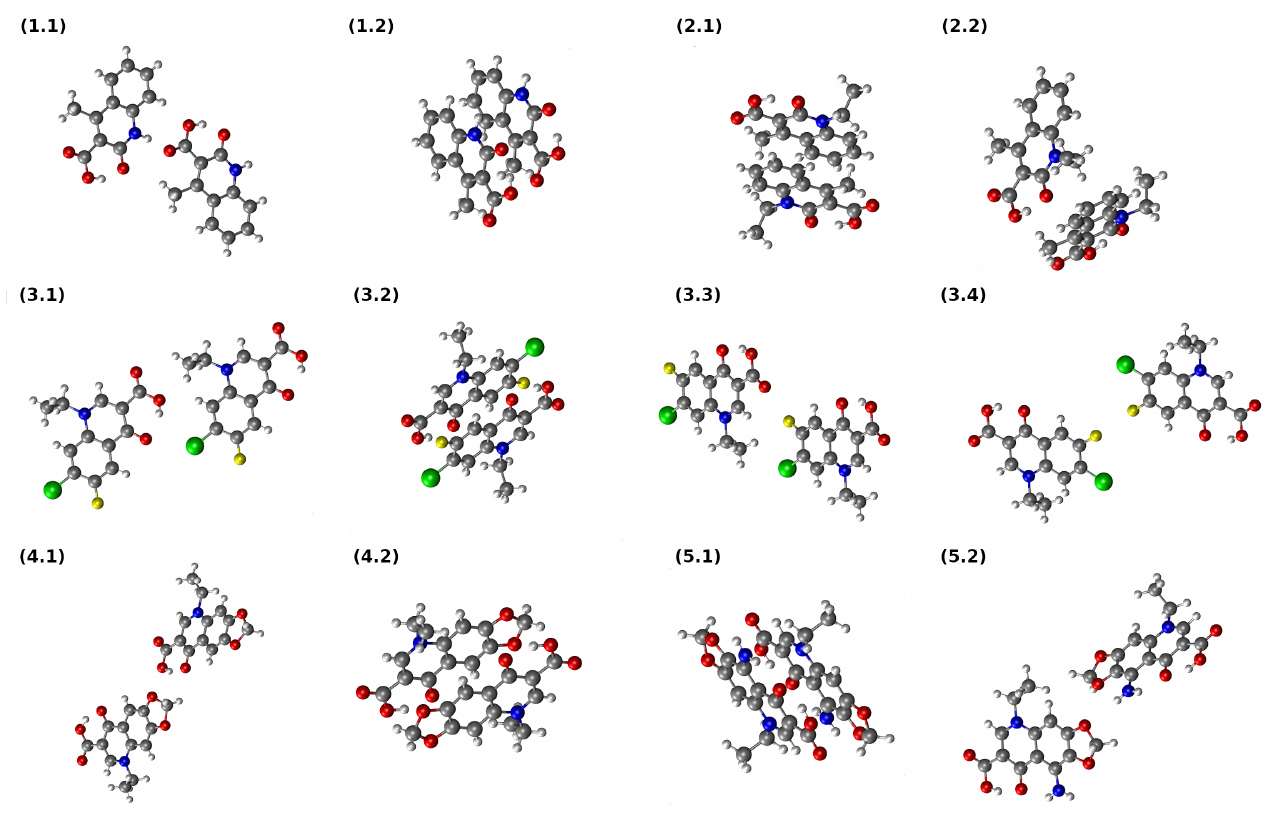
Figure 4. Dimers of the quinolone carboxylic acid derivatives extracted from the X-ray data and studied based on the SAPT. Atom colour coding: oxygen atoms, red; hydrogen atoms, white; carbon atoms, grey; chlorine atom, green; fluorine atoms, yellow; and nitrogen atoms,